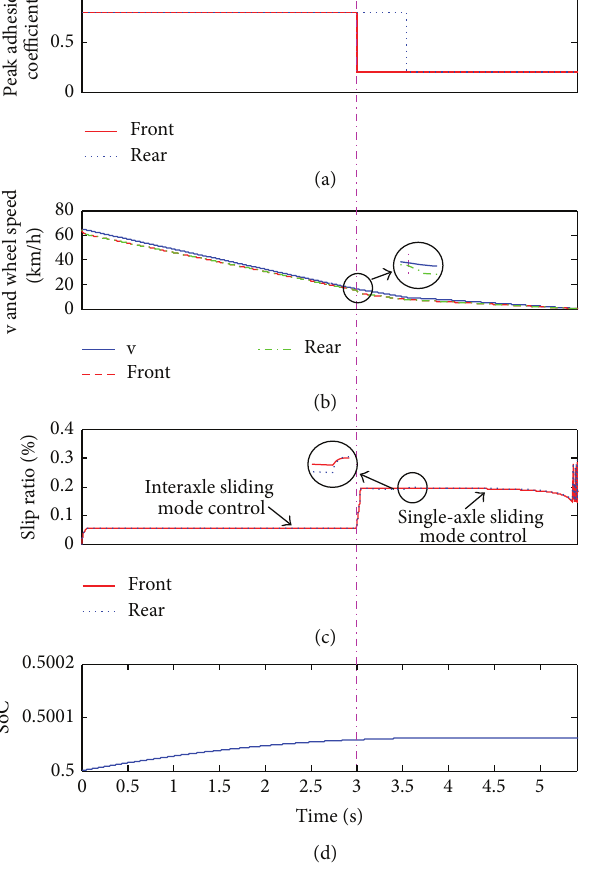
The braking severity was defined as 0.3, and load case 1 was